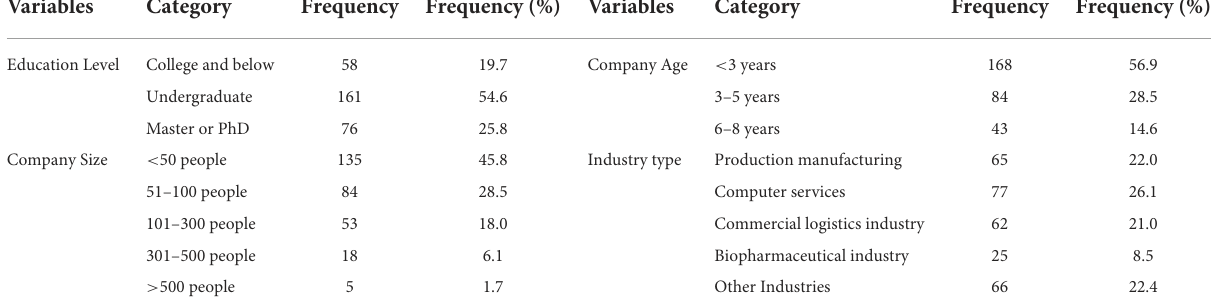
TABLE 1 Distribution of sample